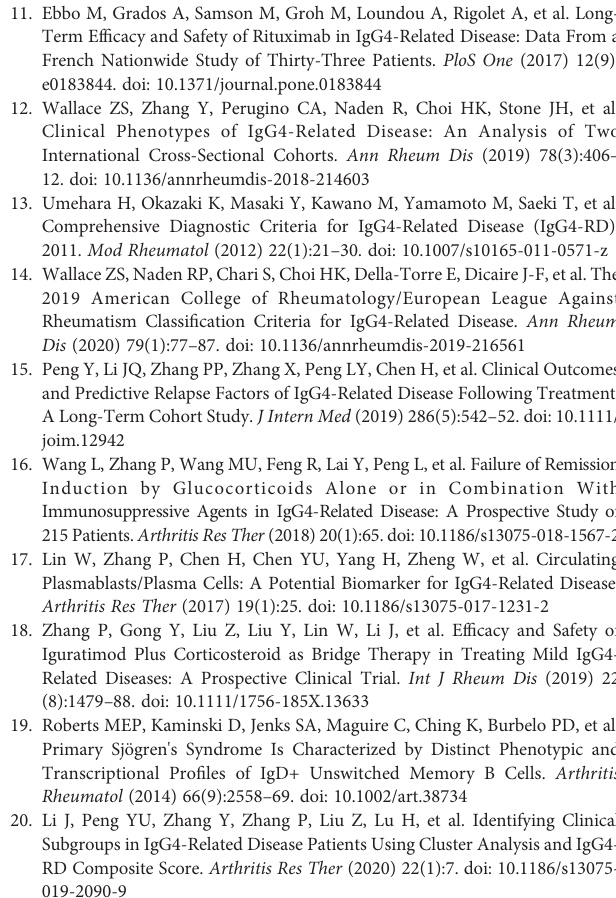
Supplementary Figure 1 | Flow cytometry analysis of B cell subsets. (A) Gating strategy ofB-cellsubsets. (B) Highpercentage ofplasmablastsand memory Bcells in active IgG4-RD. SMB, CD19+IgD-CD27+ switched memory B cell, UMB, unswitched memory B cell. Supplementary Figure 2 | Results of hierarchical statistical cluster analysis based on immune cells in 105 IgG4-RD patients. Supplementary Figure 3 | Results of scatter gram based on B cell subsets in 105 patients with IgG4-RD. (A) The three-dimensional diagrams based on CD19+ CD24-CD38hi plasmablast,CD19+CD24hiCD38hi Breg, andCD19+CD24+CD38- memory B cell. (B) The three-dimensional diagrams based on CD19+